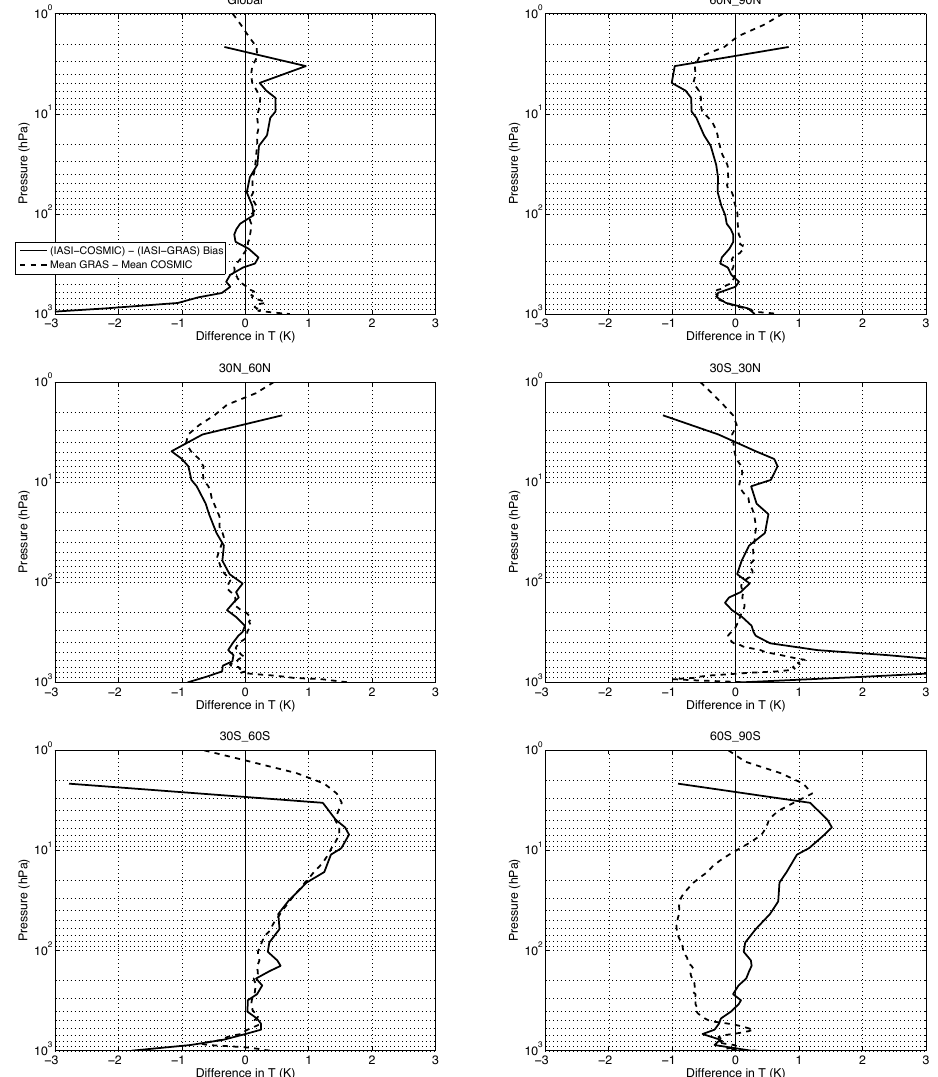
Figure 6. May 2012 (NOAA IASI minus COSMIC) minus (NOAA IASI minus GRAS) bias (solid) and mean GRAS minus mean COSMIC (dashed) for global and selected latitude